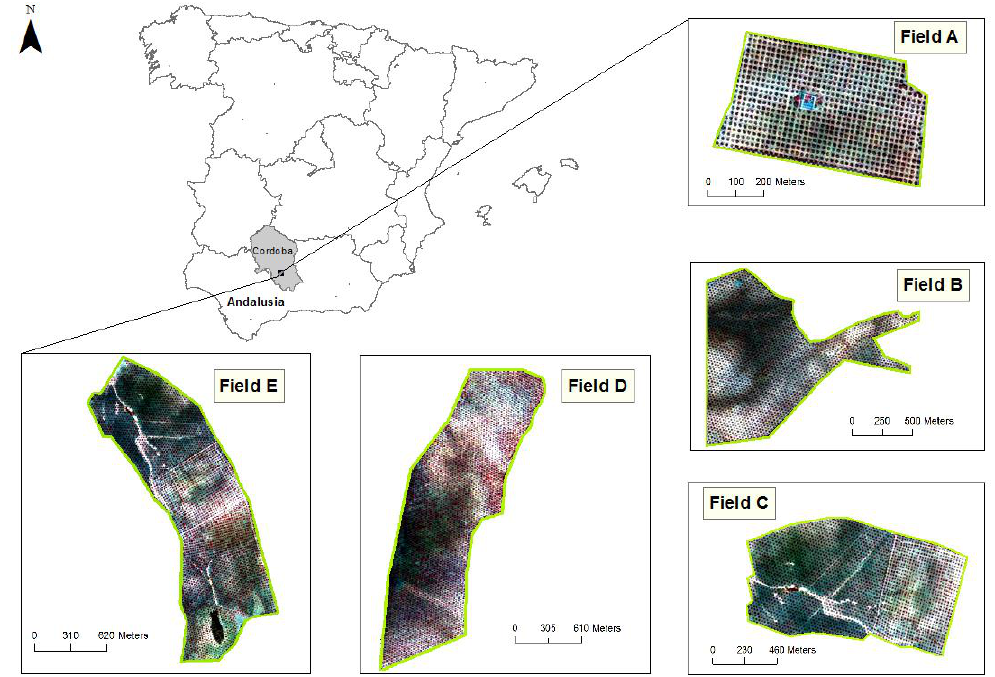
Figure 1. Location of the study area in Andalusia, southern Spain. Detailed olive orchards fields are depicted by QuickBird pansharpened images.